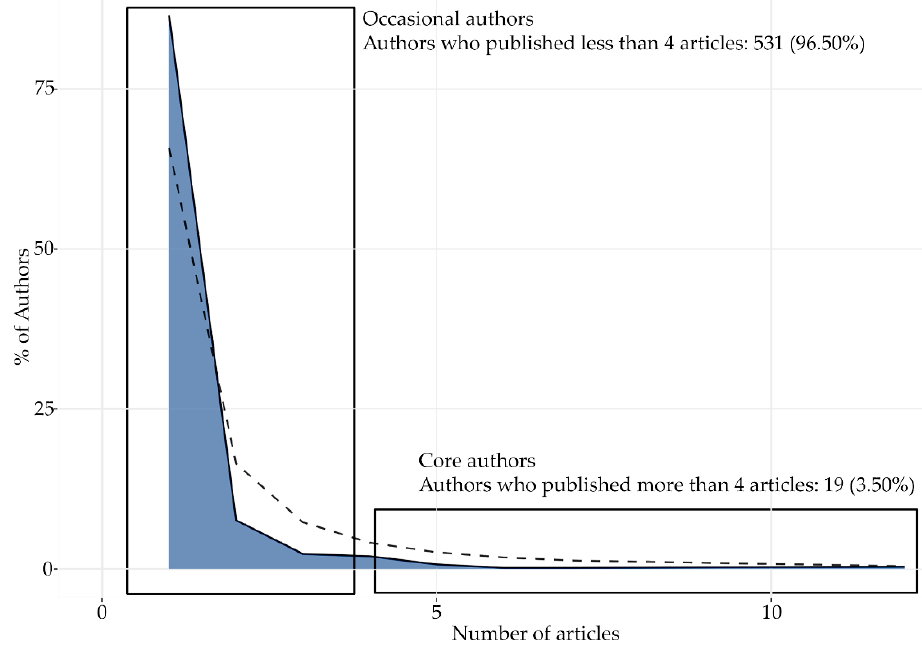
Figure 16. Lotka’s law graph. Occasional and core authors. Software: BiblioShiny version 3.0.